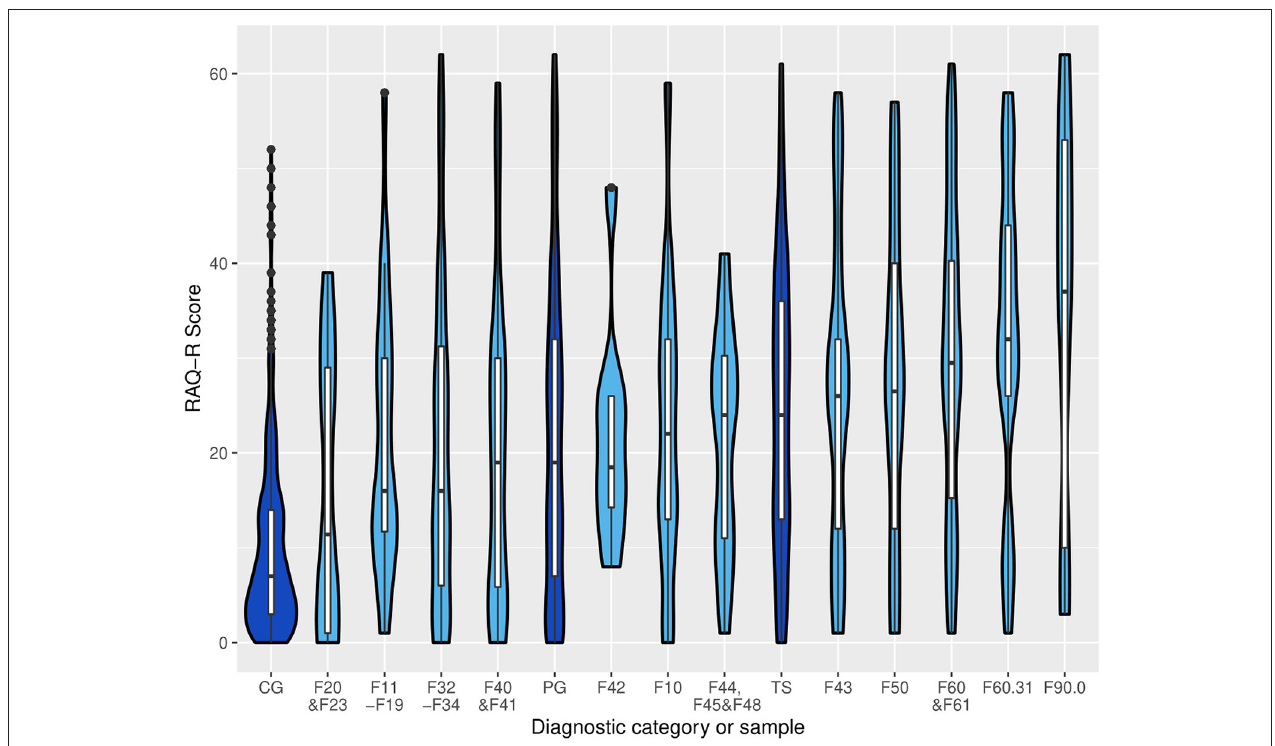
FIGURE 2 | Violin plots displaying the distribution of RAQ-R scores in controls (CG), patients with Tourette syndrome (TS), mixed psychiatric group (PG), as well as diagnostic categories according to ICD-10 with n ≥ 8. CG = control group, F20 and F23 = schizophrenia and other psychotic disorders, F11–F19 = mental and behavioral disorders due to psychoactive substance use besides alcohol, F32–F34 = depression, F40 and F41 = anxiety disorders, PG = psychiatric group, F42 = obsessive-compulsive disorders, mental and behavioral disorders due to use of alcohol, F44, F45, and F48 = dissociative and somatoform disorders, TS, Tourette syndrome (F95.2), F43 = reaction to severe stress and adjustment disorders, F50 = eating disorders, F60 and 61 = personality disorders, F60.31 = borderline personality disorder, F90.0 = attention deficit/hyperactivity disorder. Dark blue: CG, PG, TS. Light blue: diagnostic categories within the PG. Groups and categories are sorted by median.